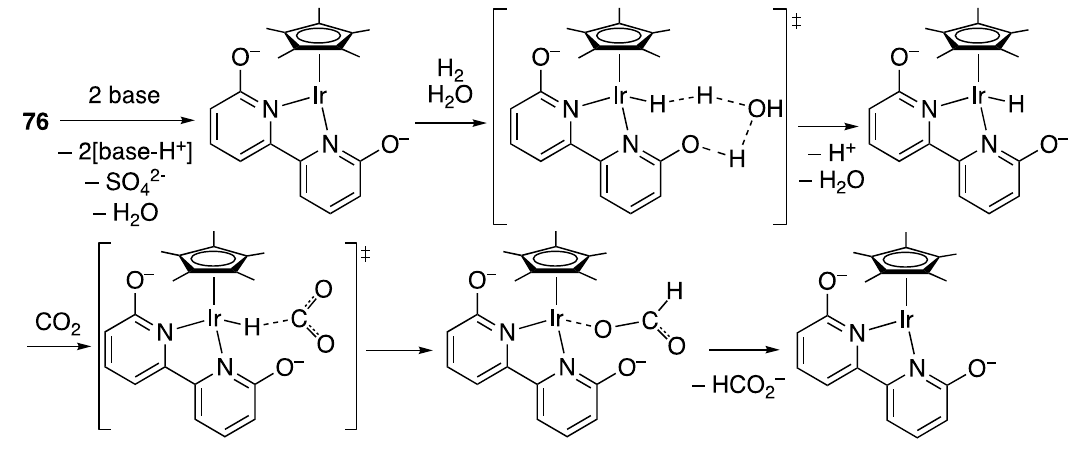
Scheme 57. Plausible mechanism for the hydrogenation of CO 2 to formate catalyzed by 76